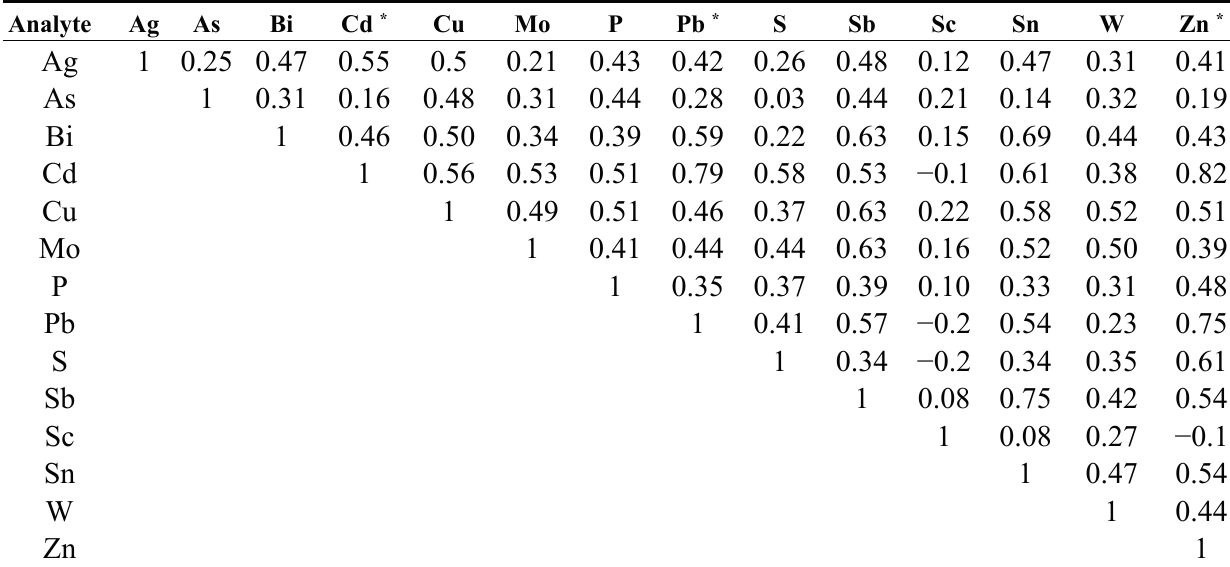
Table 3. Correlation matrix of trace metals. Highlighted values represent significantly strong correlation